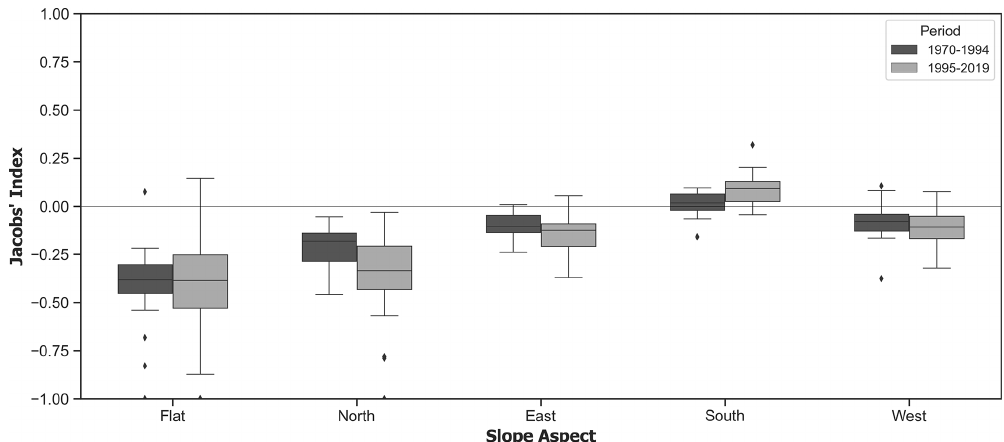
Figure 11. Box plot representing the distribution of the Jacobs’ index (ranging from − 1 to + 1) for 1970–1994 (left) and 1995–2019 (right) according to the slope aspect. The (i) median value (50th percentile; bar within the box), (ii) first quartile (25th percentile; bottom part of the box), and (iii) third quartile (75th percentile; top part of the box) are shown. Whiskers represent observations outside the middle 50%, and points represent